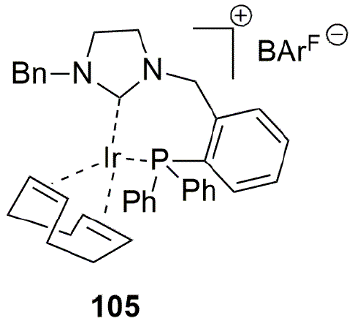
Figure 7. An Ir(I) complex with NHC ‐ P donor [150].